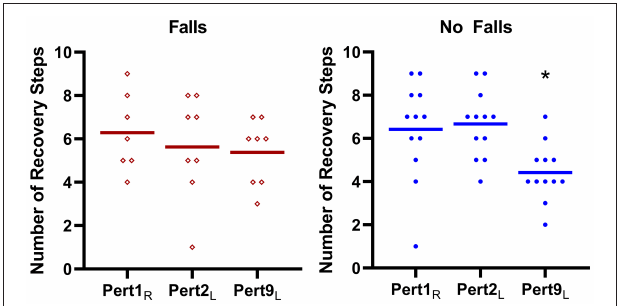
FIGURE 3 | The number of recovery steps (means and individual values) required by the Falls group (left panel) and No Falls group (right panel) for the first, second and ninth perturbations (Pert1 R , Pert2 L , and Pert9 L , respectively). *Significant difference to Pert1 R and Pert2 L